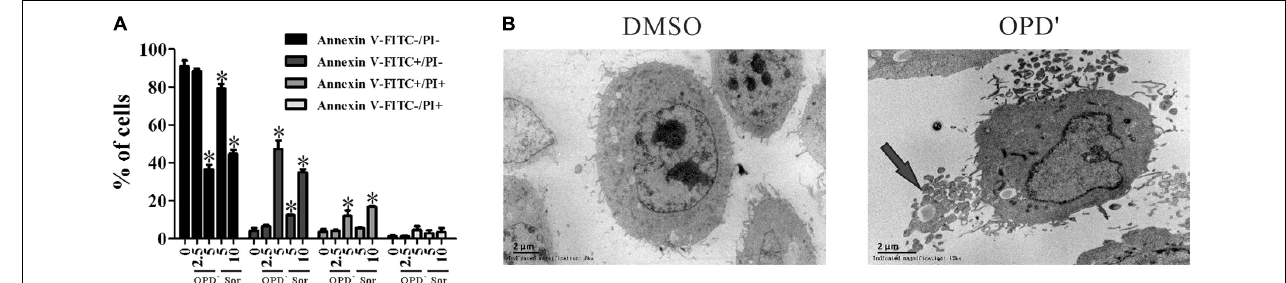
FIGURE 2 | OPD (cid:48) induced PC3 cell apoptosis. (A) The Annexin V-FITC/PI assay was used check the apoptosis of PC3 cells treated with various concentrations of OPD (cid:48) or Sorafenib for 18 h. Data are presented as the means ± SD; Sor, Sorafenib. n = 3 independent experiments. ∗ p < 0.05 vs. 0 µ M. (B) Transmission electron microscopy (TEM) images of untreated and 5 µ M OPD (cid:48) -treated (6 h) PC3 cells. Arrow: apoptotic body.